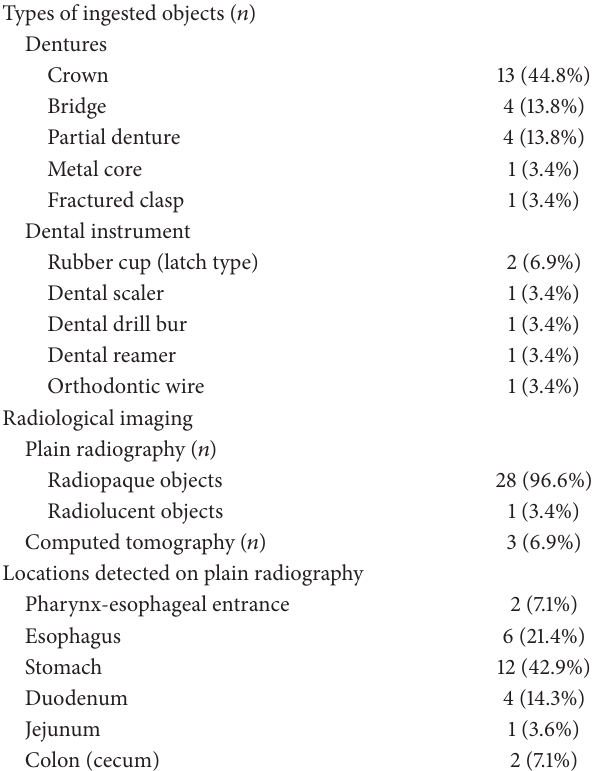
Table 2: Ingested dental objects.